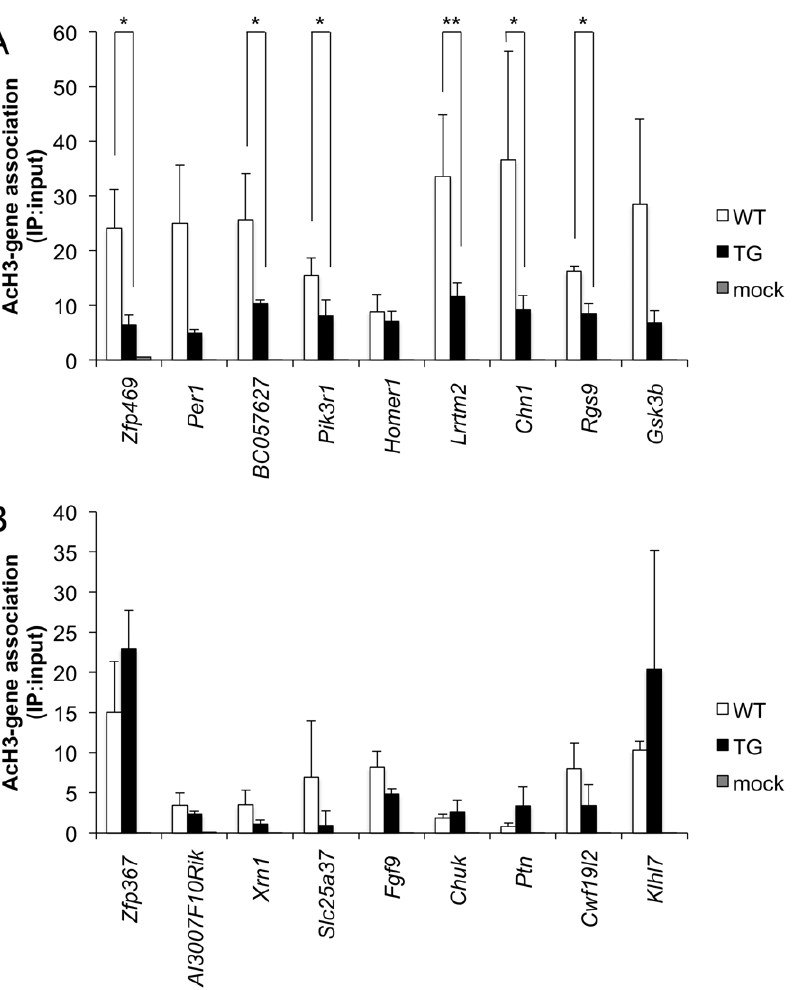
Figure 6. Single gene ChIP confirmation of differentially acetylated genes. (A) Genes with decreased acetylation as predicted by their composite score. (B) Genes with increased acetylation as predicted by their composite score. The order of the genes from left-right indicates their relative ranking by composite score. *, p-value , 0.05; **, p-value , 0.01. White bars, WT; black bars, TG; grey bars, mock condition. Error bars are standard deviation.